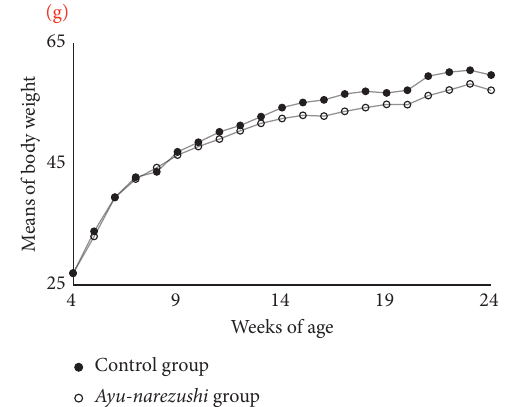
Figure 1: Comparison of changes in mean body weight between the ayu-narezushi and the control groups from 4 to 24 weeks of age. The mean body weight of the ayu-narezushi group ( n � 5, white circles) was lower than that of the control group ( n � 5, black circles) over 10 weeks of age. This trend continued until 24 weeks of age, with a gradual increase in the difference in mean body weight between the two groups over the weeks.